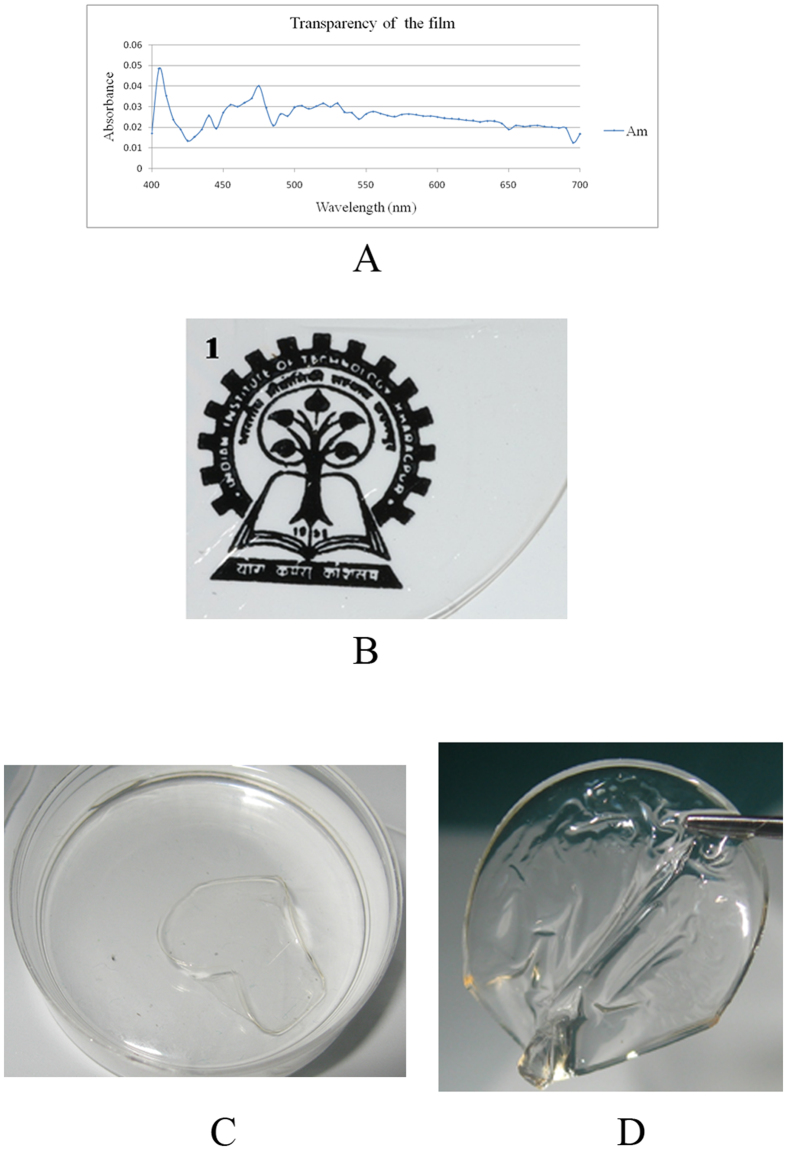
Determination of transparency of Am films.Absorbance spectra of transparent thin films of Antheraea mylitta (Am) fibroin were generated using a Multiskan spectrum. Scanning was performed from 400 to 700 nm wavelength range with 5 nm intervals. The graph (A) shows that the film has an absorbance of 0.01 – 0.04 in the visible range (400–700 nm); transparency was calculated using Beer’s law. Visual appearance of 2D transparent thin film made of Am fibroin, the image can be clearly visualized through the transparent film (B). Films were very thin with smooth surface (C) and easy to handle (D).